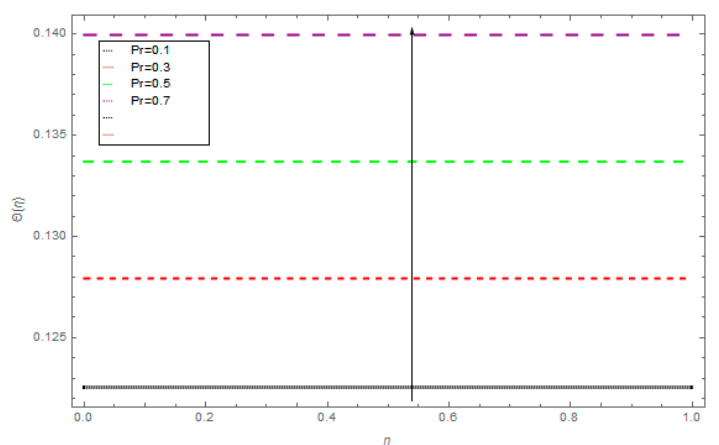
Figure 10. The influence of the Schmidt number ( Sc) on ϕ ( η ) when Nb = 0.6, Nt = 0.5.